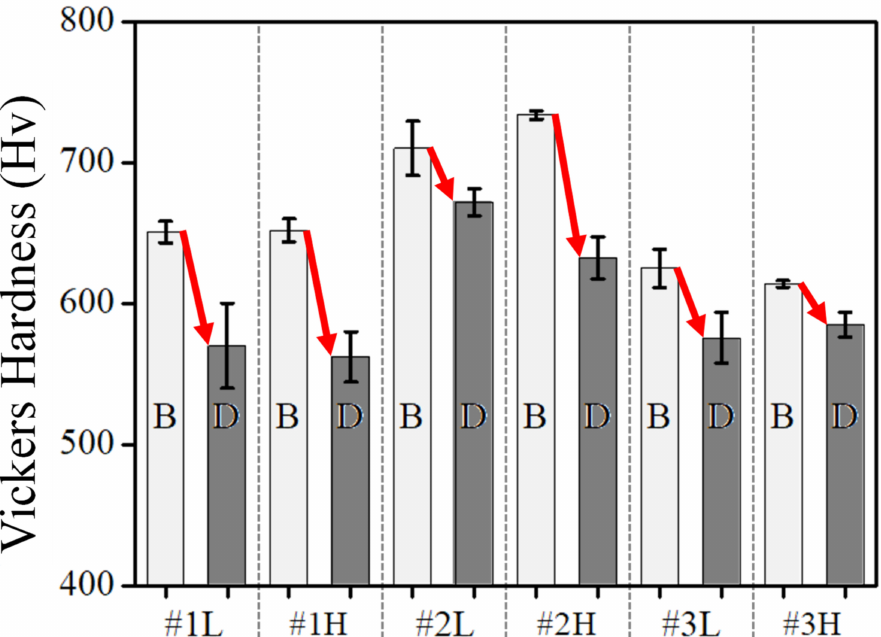
Figure 4. Vickers hardness of the Ti-based BMGs. B: bright region; D: dark region in the optical